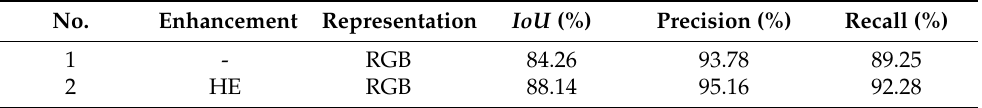
Table 6. The effect of image